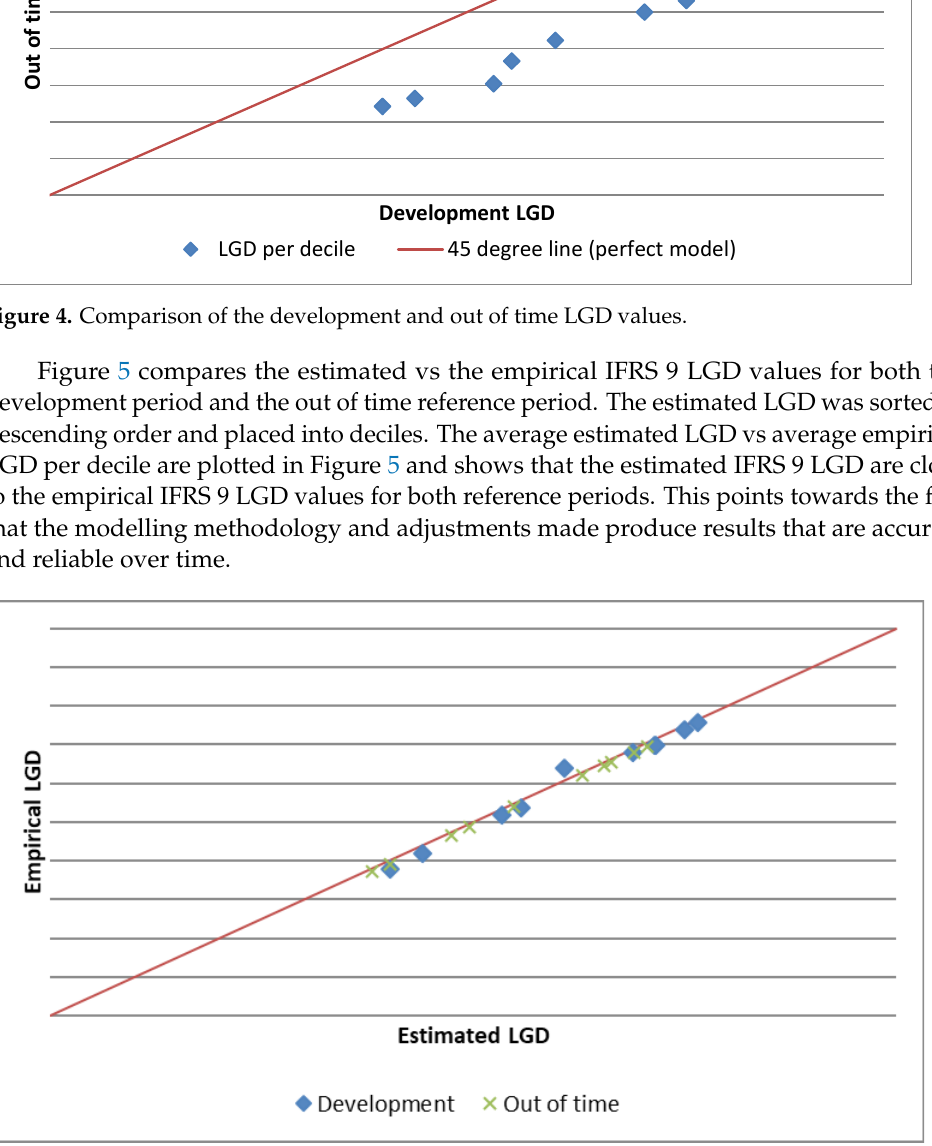
Figure 5. Estimated vs the empirical IFRS 9 LGDs for the development and out of time reference